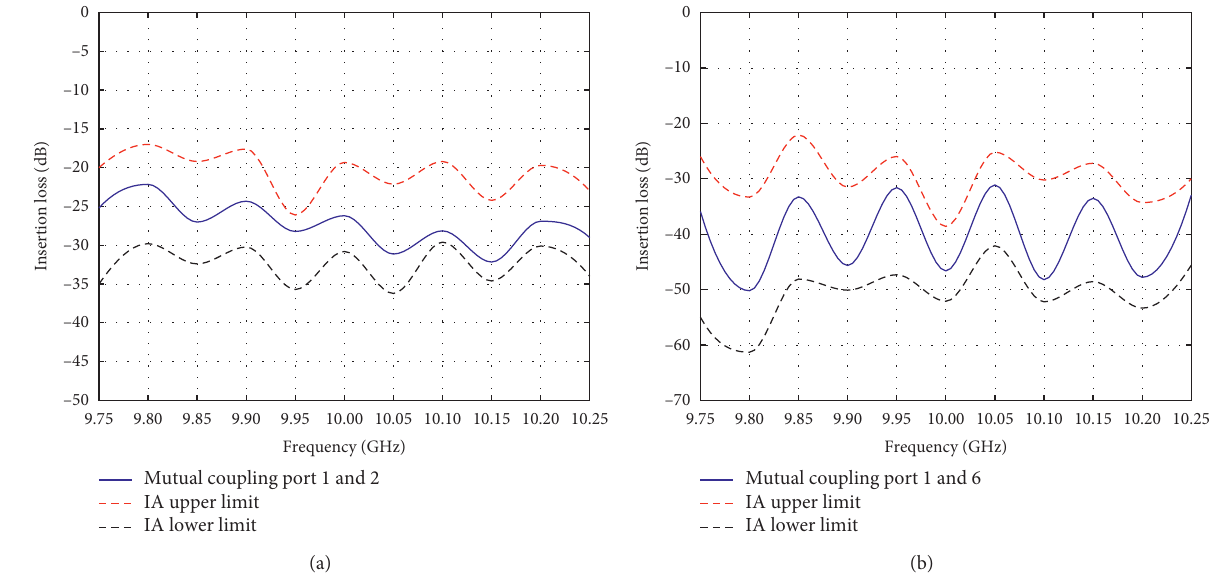
Figure 26: Measurement of the coupling factor between (a) ports P1 and P2 and (b) ports P1 and P6.